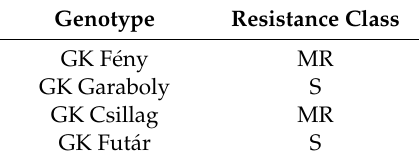
Table 2. Winter wheat genotypes in the tables and figures, Szeged,